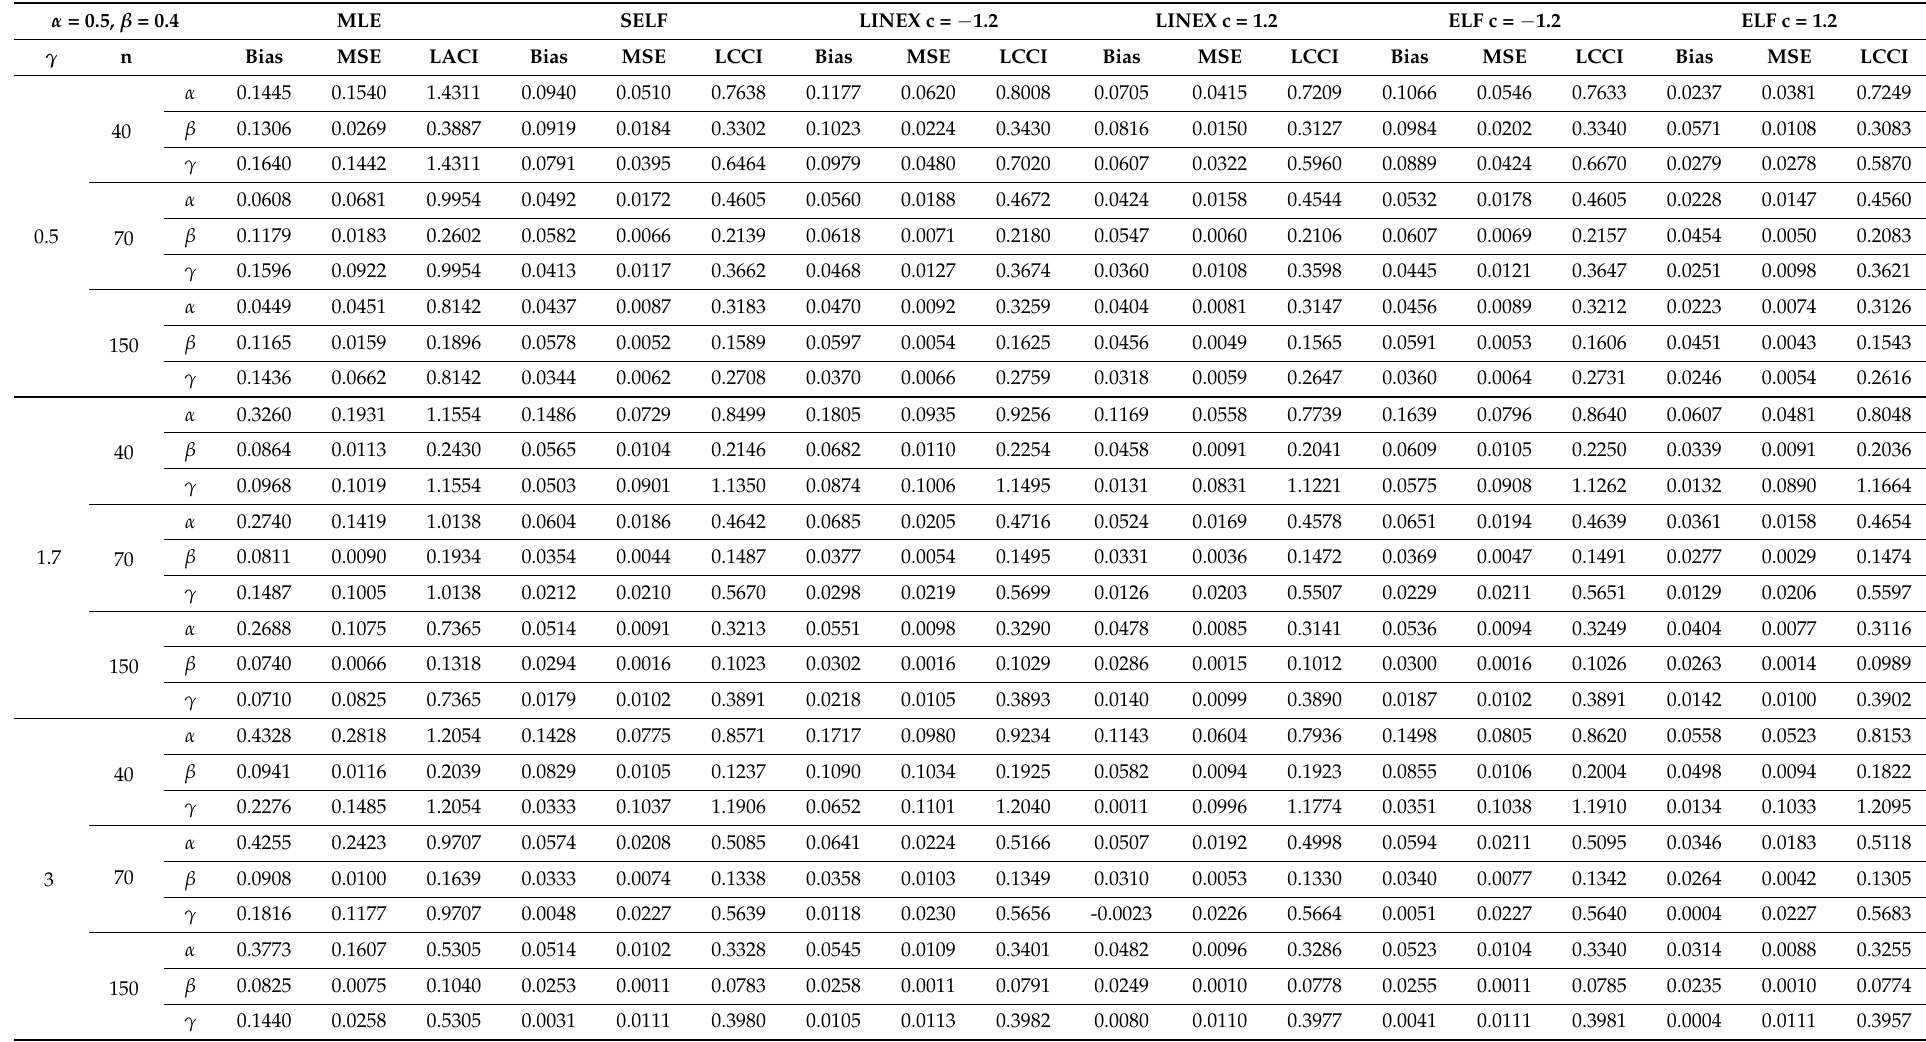
Table 3. Bias, MSE and LCI for MLE and Bayesian estimation methods for α = 0.5, β =